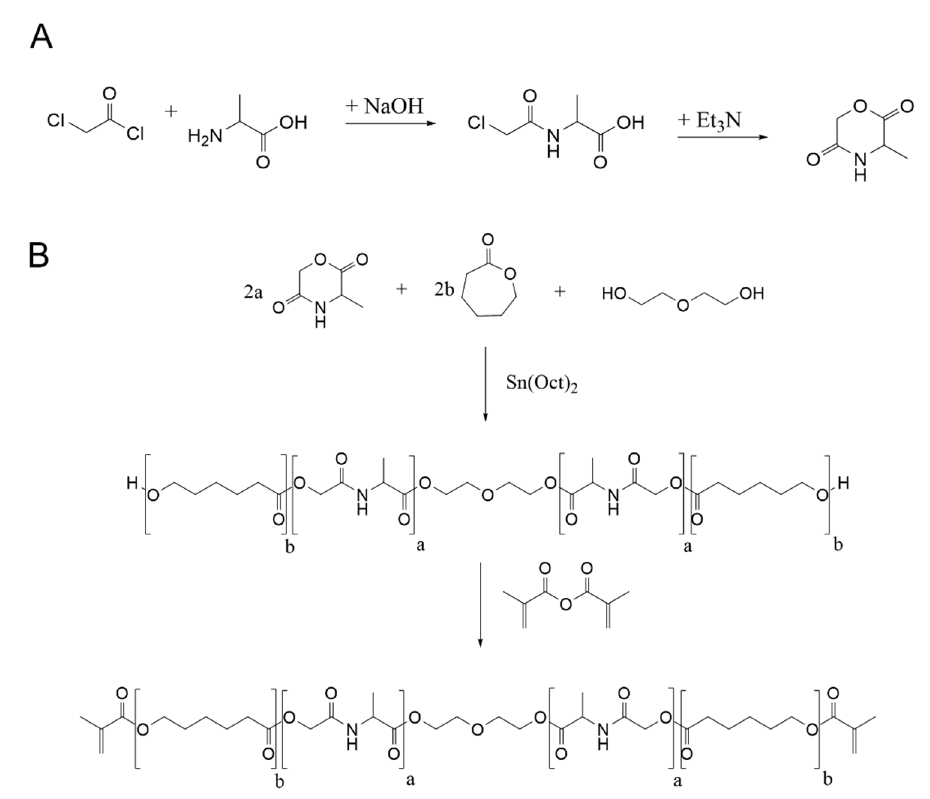
Figure 1. Synthesis of ( A ) Cyclic monomer: N-Morpholino-2,5-dion and ( B ) Poly-(Alanine- ε - Caprolacton)dime thacrylate (a…2, 4, 6, 8 and b…8, 6, 4, 2).